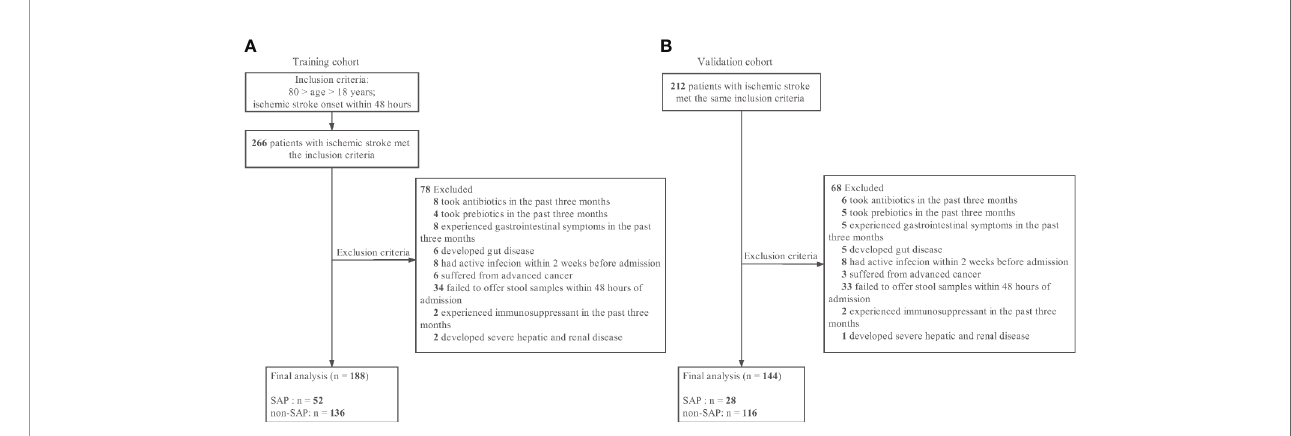
FIGURE 1 | Patient fl owcharts. (A) The training cohort. (B) The validation cohort. SAP indicates